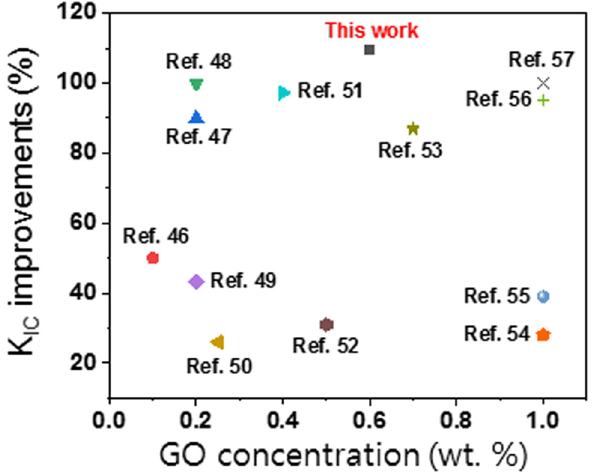
Figure 9: Comparison of the K IC improvements of GO - loaded epoxy